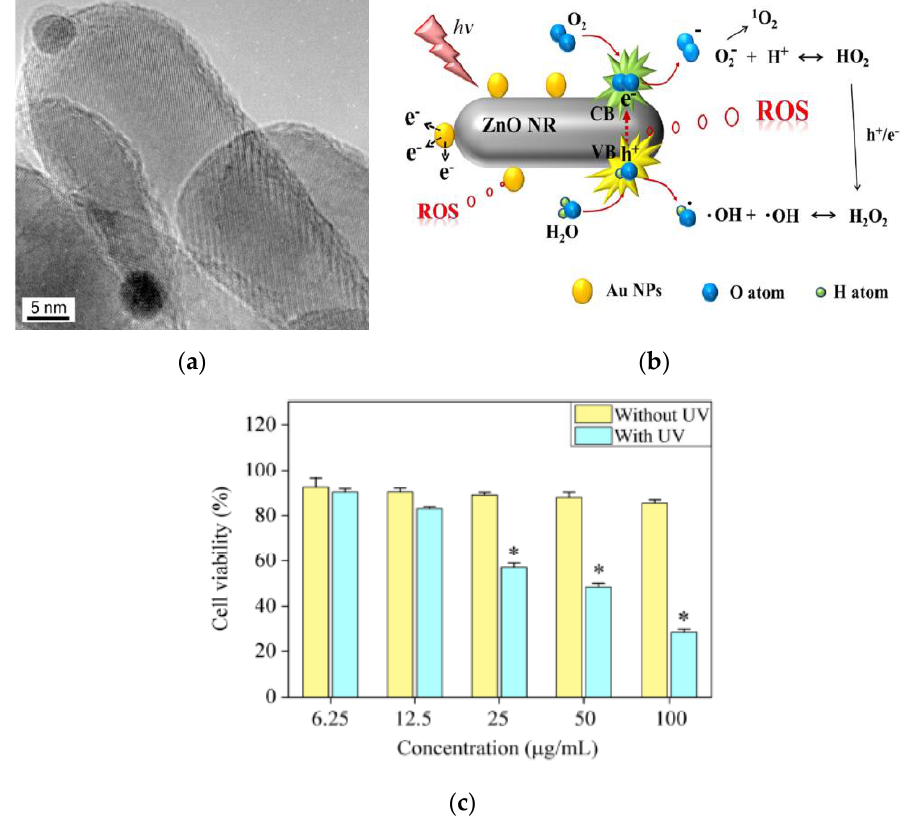
Figure 31. ( a ) TEM image of ZnO:AuNPs nanohybrid. Dark grey particles: AuNPs. ( b ) A schematic showing a high yield production of ROS on ZnO:AuNPs under UV irradiation. ( c ) MTT cell viability of HeLa cells treated with ZnO:AuNPs (molar ratio 20:1) of di ff erent concentrations with or without UV irradiation. Data are expressed as mean ± SD, n = 3, * denotes a statistical di ff erence between HeLa cells with and without UV irradiation. Reproduced from [167] with permission of Springer Nature.